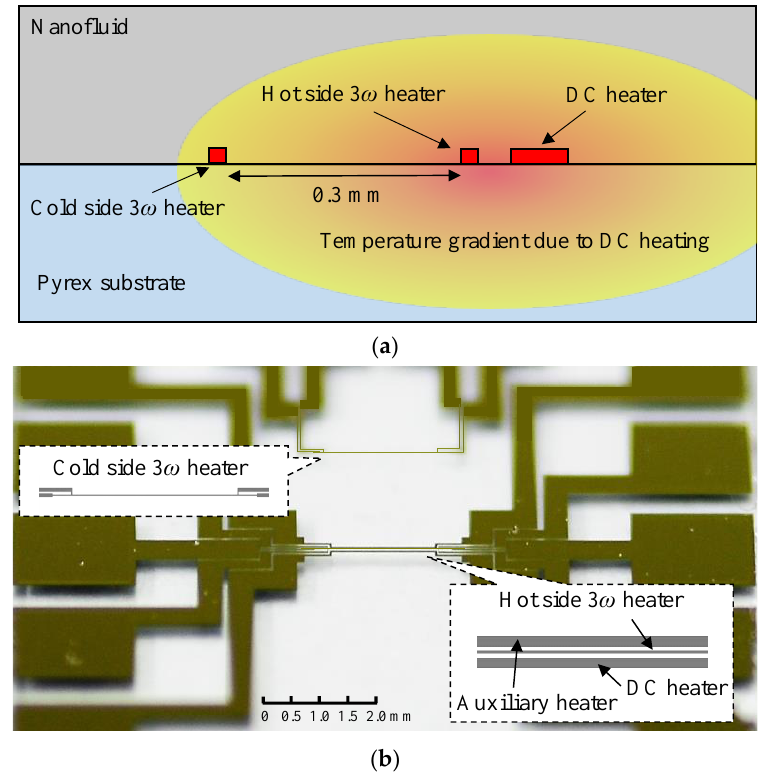
Figure 1. ( a ) Schematic representation of the thermal conductivity measurement of a nanofluid with a temperature gradient using the 3 ω method, and ( b ) photograph of metal heaters on a Pyrex substrate used as 3 ω and direct current (DC) heaters.